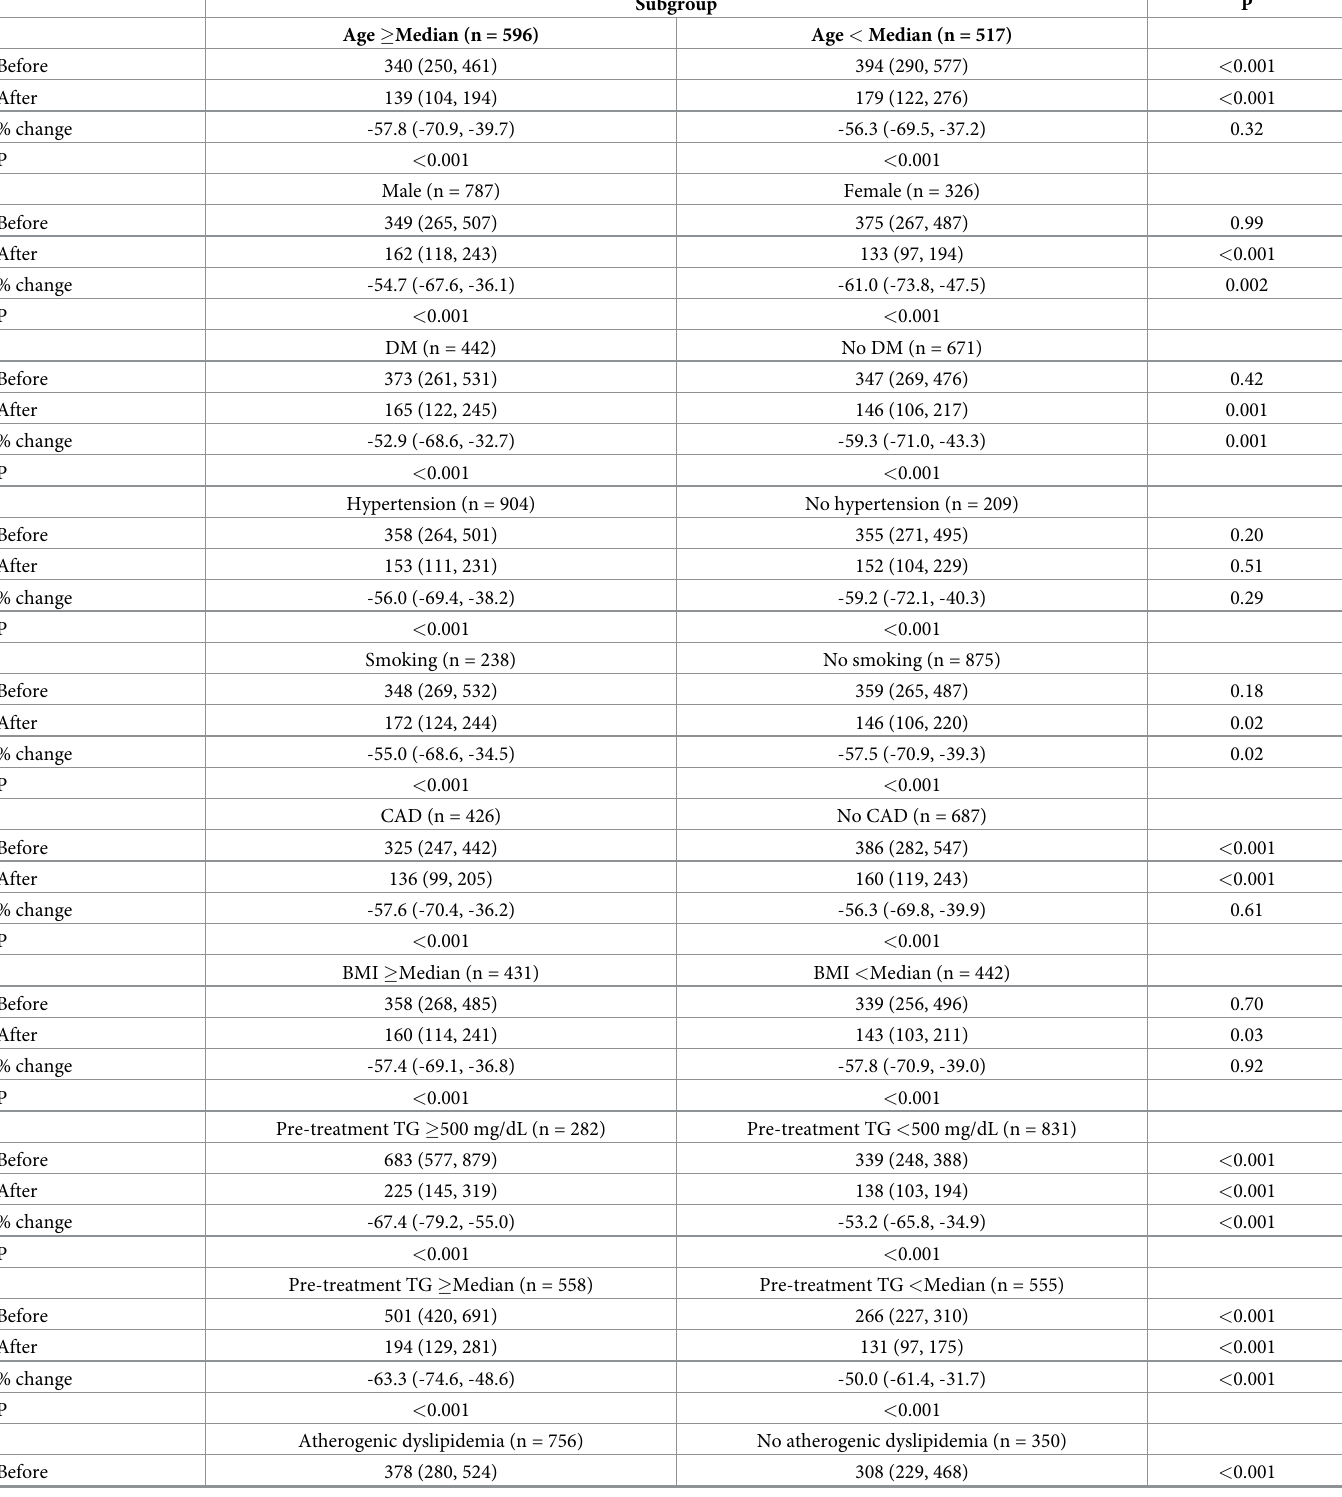
Table 2. Subgroup analysis for changes of TG after treatment with